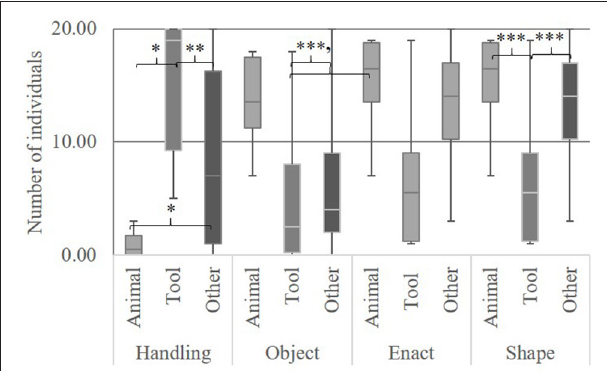
FIGURE 4 | Representation techniques used by number of individuals for tools, animals and other. Error bars show SD ’ p < 0.070, * p < 0.050, ** p < 0.010, *** p <